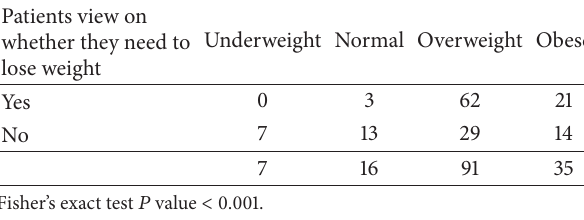
Table 4: Patients’ perceptions on whether they need to lose weight according to where they see themselves on the visual scale.